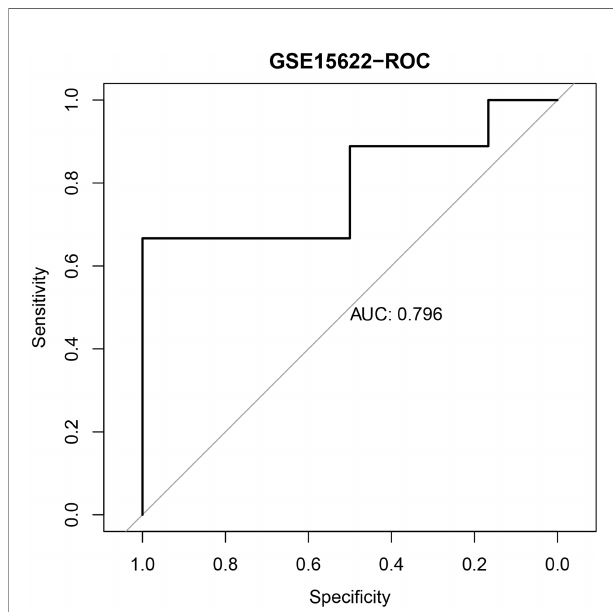
FIGURE 2 | The ROC curve of the IPR signature in prediction the platinum resistance in the validation cohort